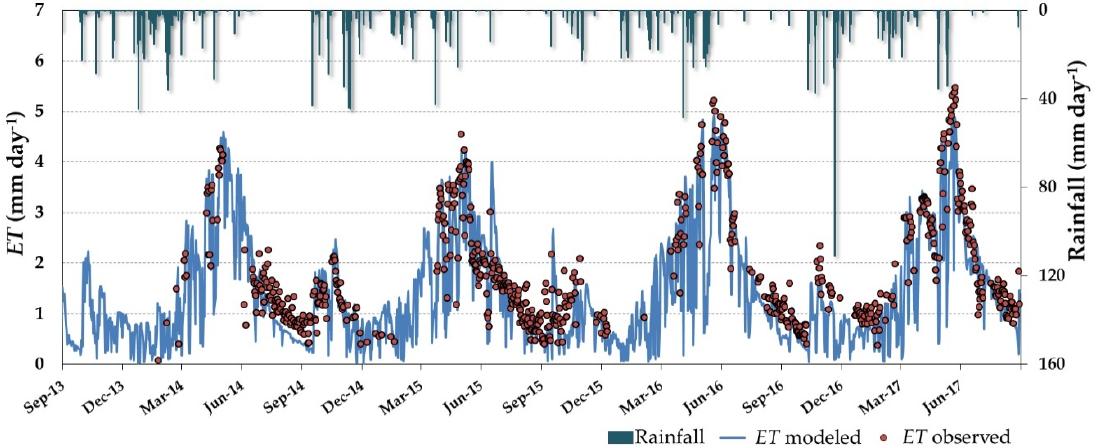
Figure 6. Daily evapotranspiration ( ET ) monitoring over the dehesa ecosystem, considering basal crop coefficients for full cover vegetation , K cb full = 1, and the depletion fraction, p = 0.5. Dark green bars illustrate rainfall events.